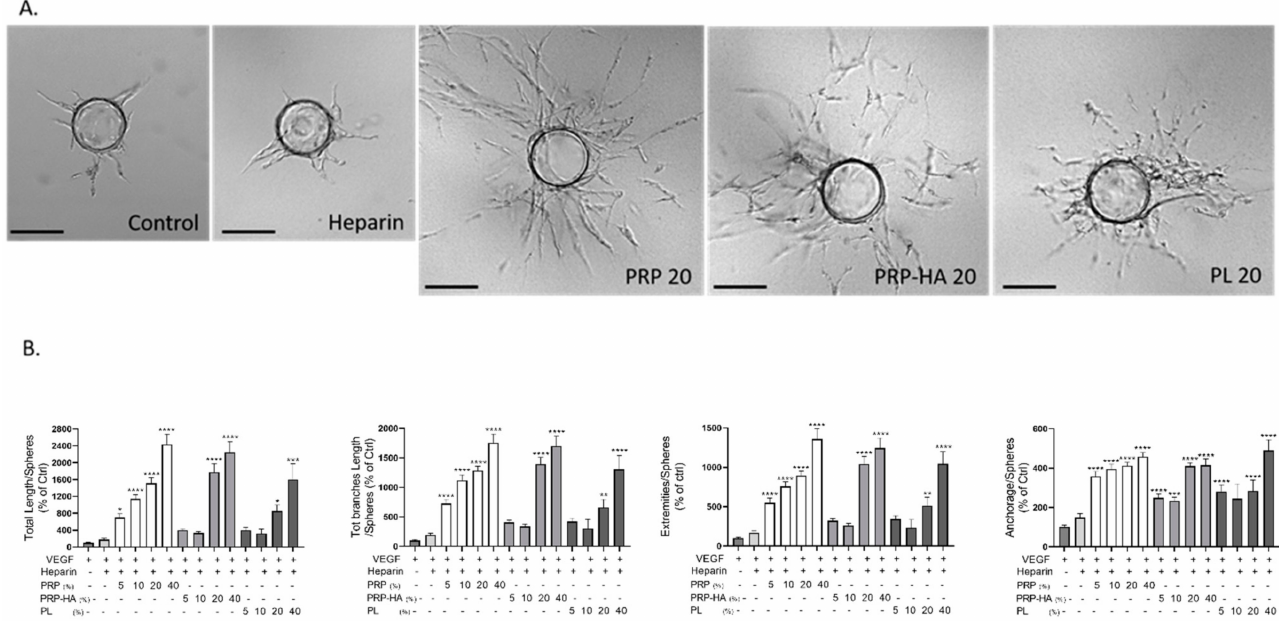
Figure 3. Platelet-derived products differentially modulated angiogenesis in a 3D fibrin gel. ( A ) 3D HUVEC cultures were treated with either PRP, PRP-HA or PL for 4 days. Representative images showing massive enhancement of angiogenesis (20% PRP, 20% PRP-HA) or slight endothelial proliferation from the EC coated beads (20% PL) compared to control conditions (control and heparin) at day 4. Scale bar: 150 µ m. ( B ) Quantification of morphometrical parameters of the capillary network was performed by a computerized method on images taken on day 4. Representative parameters measured were total length, total branch length, number of extremities and number of anchorage junctions per sphere. Graphs are representative of three independent experiments. One hundred spheres were quantified for each experimental condition and compared to the heparin-treated cultures. Significant from heparin as measured by the one-way ANOVA followed by Dunett’s multiple comparison test (* p < 0.05, ** p < 0.01, *** p < 0.005, **** p <